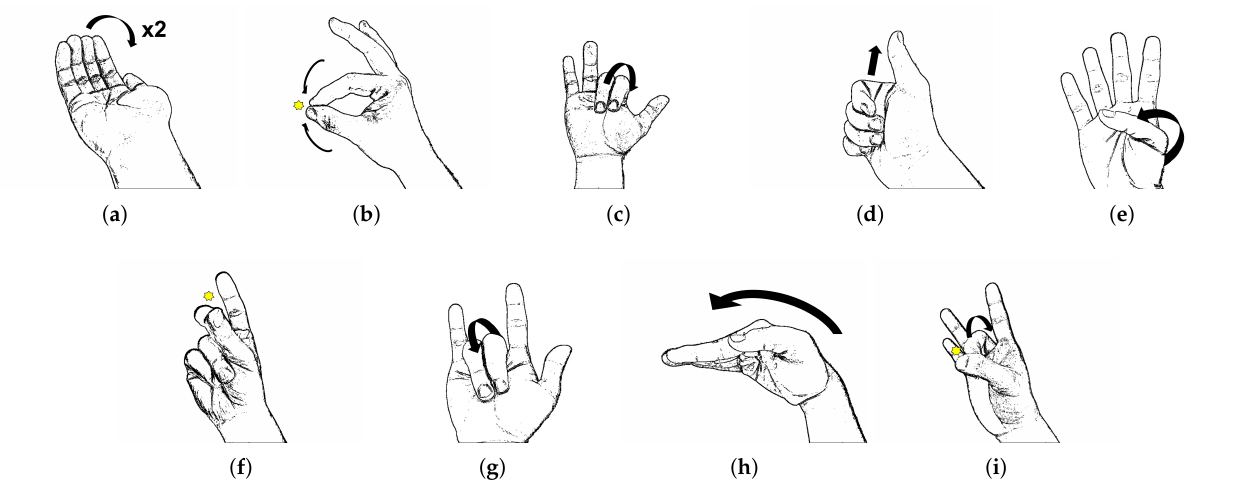
Figure 3. Hand gesture examples: ( a ) Gesture 1; ( b ) Gesture 2; ( c ) Gesture 3; ( d ) Gesture 4; ( e ) Gesture 5; ( f ) Gesture 6; ( g ) Gesture 7; ( h ) Gesture 8; ( i ) Gesture 9. Gesture 1 is the motion of folding and unfolding of four fingers, excluding the thumb, twice. Gesture 2 is the motion of pinching the index finger and thumb together. Gesture 3 is the motion of folding and unfolding the index and middle fingers. Gesture 4 is the motion of bending the thumb into the other fingers, with the fingers curled, and then raising the thumb. Gesture 5 is the motion of folding and unfolding the thumb into the palm with the other fingers straight. Gesture 6 is the motion of snapping the thumb against the middle finger. Gesture 7 is the motion of bending the middle and ring fingers into the palm and slightly turning the wrist outward. Gesture 8 is a 90-degree inward bending of the